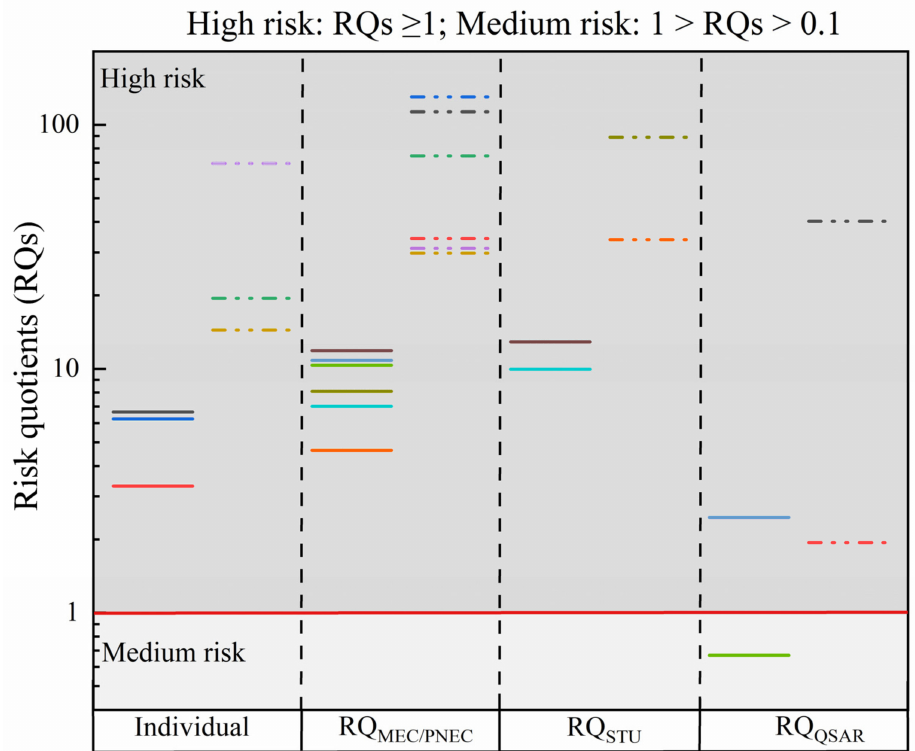
Figure 2. RQs for individual and binary mixtures obtained based on different environmental risk assessment methods. The solid line and dotted line represent the RQs in surface water and wastewa- ter,